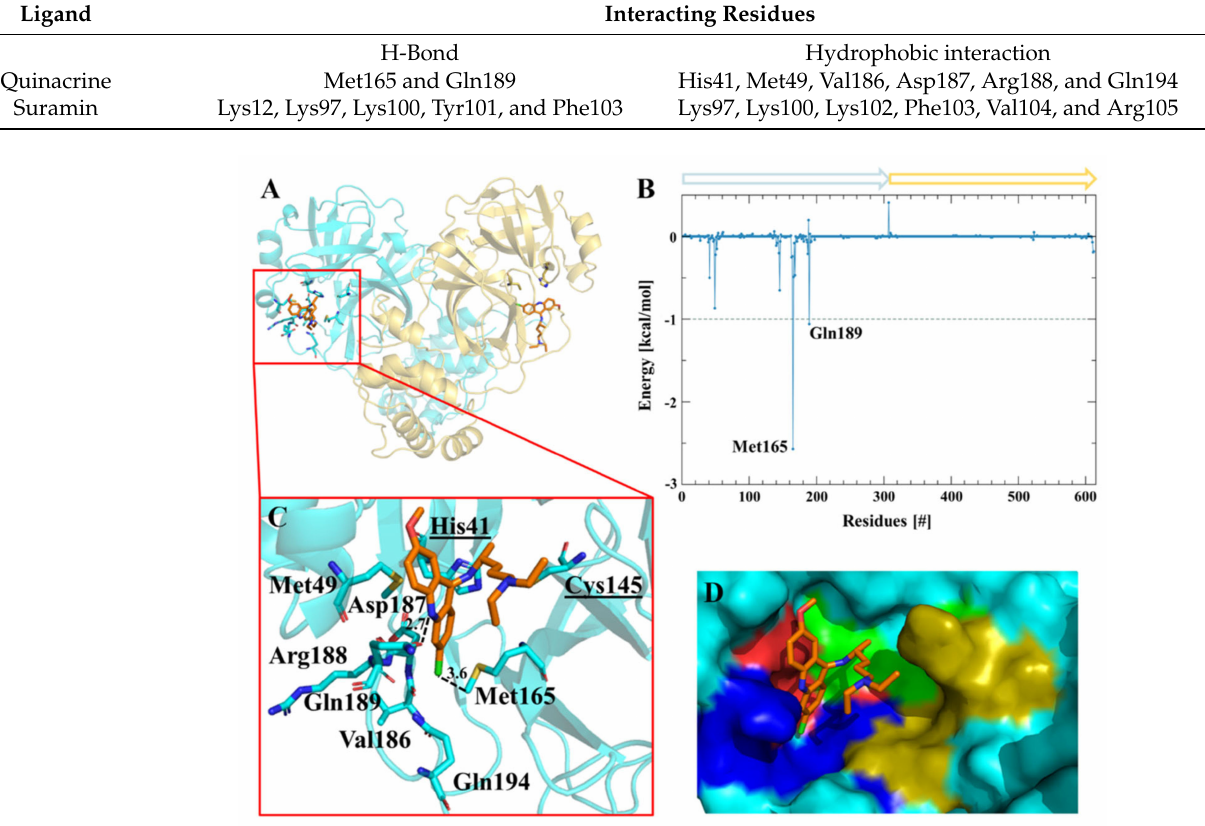
Figure 4. Amino acids participating in the SARS-CoV-2 3CL pro -quinacrine interaction. ( A ) Ribbon and sticks representation of the SARS-CoV-2 3CL pro -quinacrine complex after molecular dynamics (MD) simulation. ( B ) Decomposition of the binding energy of SARS-CoV-2 3CL pro -quinacrine complex. Arrows label protomer A (turquoise) and protomer B (gold). ( C ) SARS-CoV-2 3CL pro amino acids involved in the interaction with quinacrine based on MD simulations. ( D ) Quinacrine interaction in the protease substrate-binding and active site. The substrate-binding subsites are highlighted in green for S1’, gold for S1, red for S2, and blue for